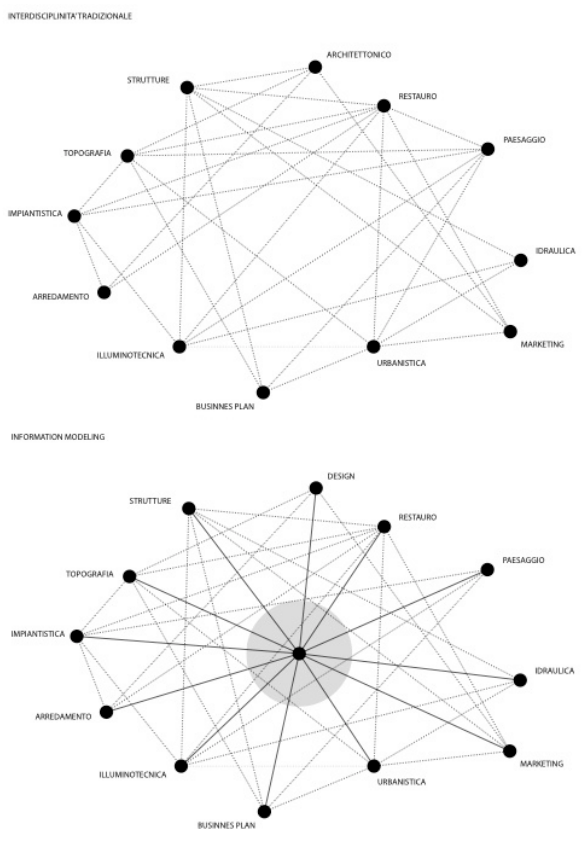
Figure 1: Top to bottom. Diagram of analysis of today's procedural system in the field of design. The disciplines are connected to each other with complex connections but do not interact in a single central model. Diagram of analysis of today's procedural system in the context of design based on information systems. The disciplines are connected to each other through a single central